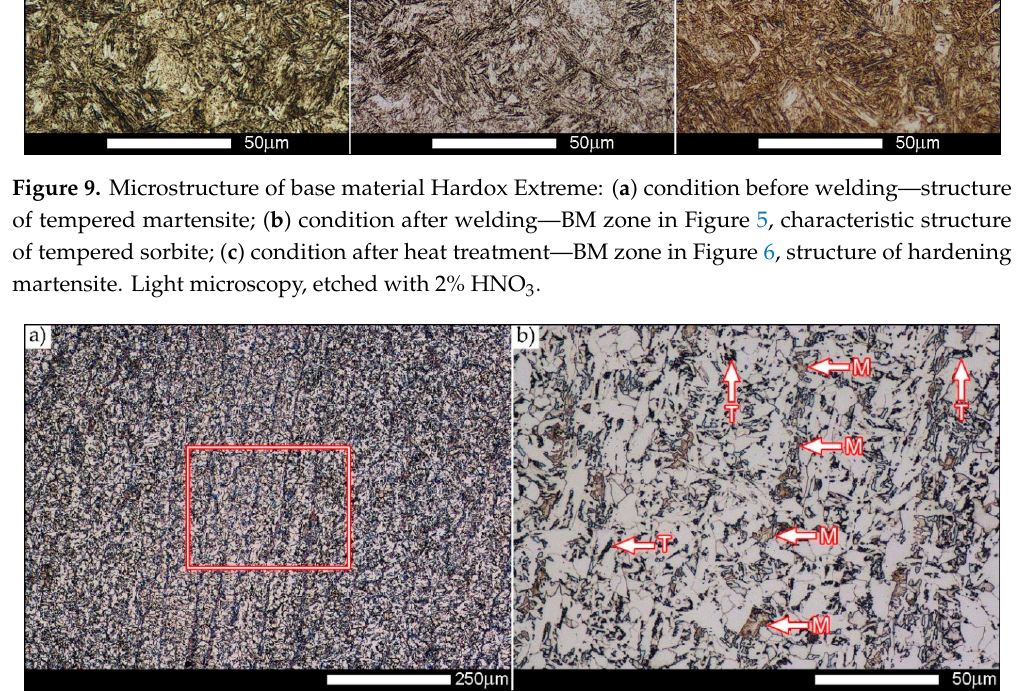
Figure 10. Microstructure of Hardox Extreme welded joint after welding: ( a ) in the area marked WM1 in Figure 5; ( b ) an enlarged image marked with frame in Figure 10a. Morphologically diverse structure composed of bands of martensite (M) with colonies of hardening troostite (T) on the background of non-equilibrium grains of ferrite. Light microscopy, etched with 2% HNO 3 . Microstructure in the zone WM2 is composed of lath hardening martensite on the background of tempered sorbite, small quantity of bainite and colonies of troostite (Figure 11). Microstructure in the transition zone between the weld layers 1 and 2 (WM3 in Figure 5) is composed mostly of hardening sorbite with band-like martensite, hardening bainite and colonies of troostite (Figure 12). It is also worth to indicate the significant change of structure in the zone WM3, which can determine general impact strength of the entire welded joint. Thus, from the viewpoint of fracture mechanics, the microstructure of the transition zone between the weld layers 1 and 2 (Figure 2) should be taken